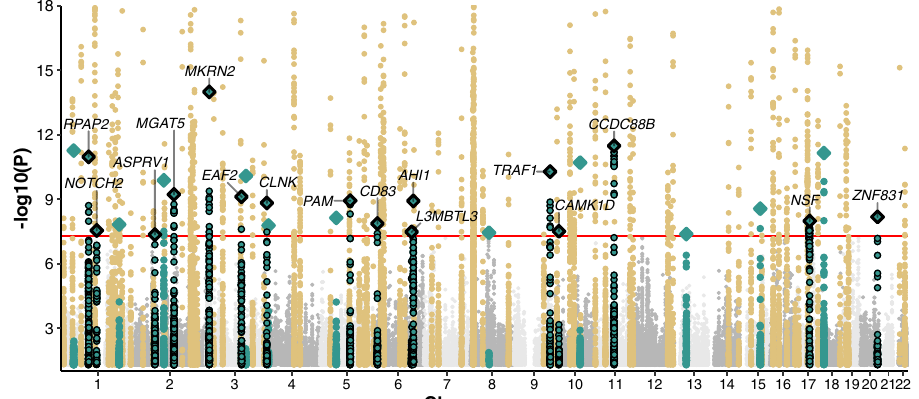
Fig. 2 | Manhattan plot of the multi-ancestry and multi-trait SLE GWAS meta- analysis. WeconsiderlocireportedintheGWAScatalog(asof12/11/2021)orinthe studiesusedinourmeta-analysisasknown(brown).Wede fi nenovelloci(green)as the ones that are 1 million base pairs away from previously reported GWAS loci. Diamonds in the plot represent sentinel variants at novel loci. Diamond with black outline represents novel loci that are replicable according to RATES. In total, we identify 79 known loci and 27 novel loci, of which 74 known loci and 16 novel loci